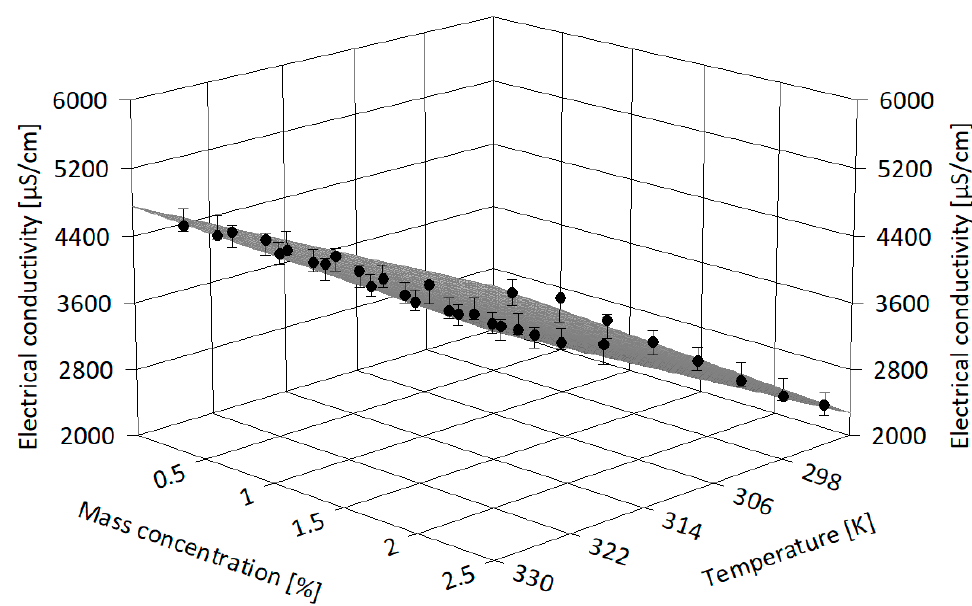
Figure 8. Three-dimensional analysis of ZnO suspensions. -For alumina suspensions: